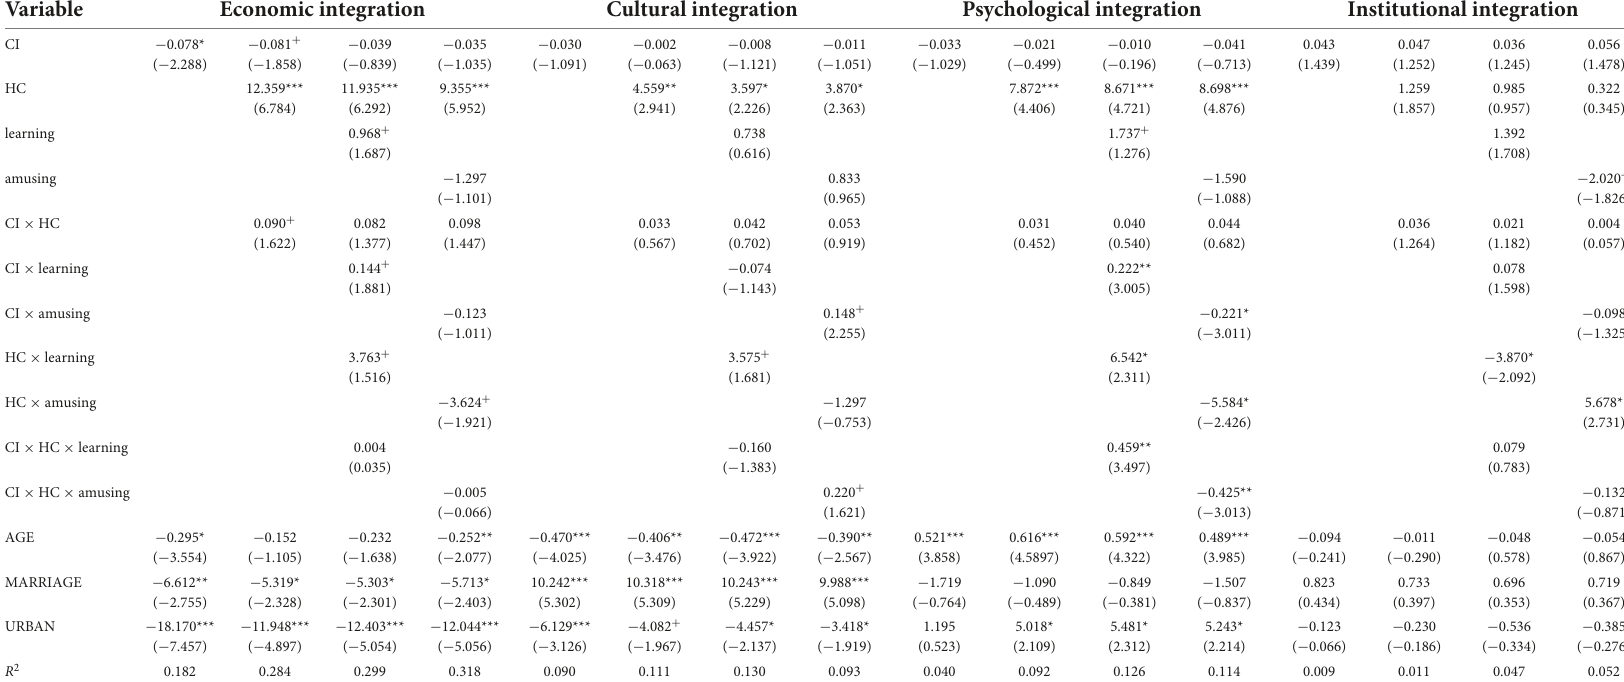
TABLE 8 Heterogeneity analysis of different social integration